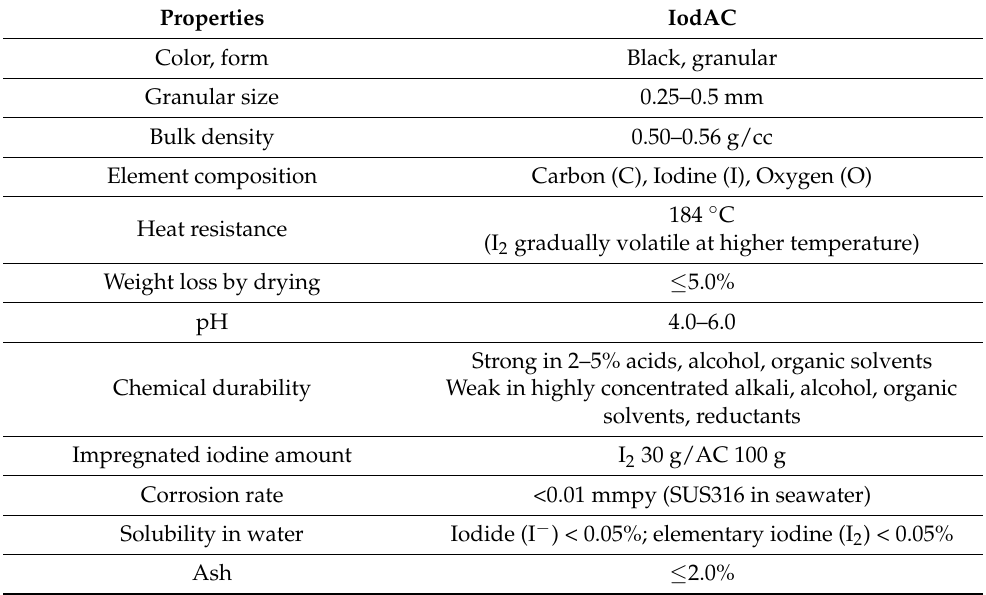
Table 1. Summary of IodAC, as IodAC (30), main characteristics.